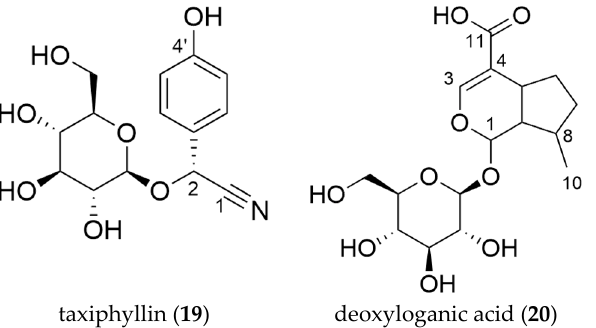
Molecules 2022 , 27 , x FOR PEER REVIEW Figure 7. Low energy ESI MS/MS spectrum of taxiphyllin ( 19 ). Figure 7. Low energy ESI MS/MS spectrum of taxiphyllin ( 19 ).